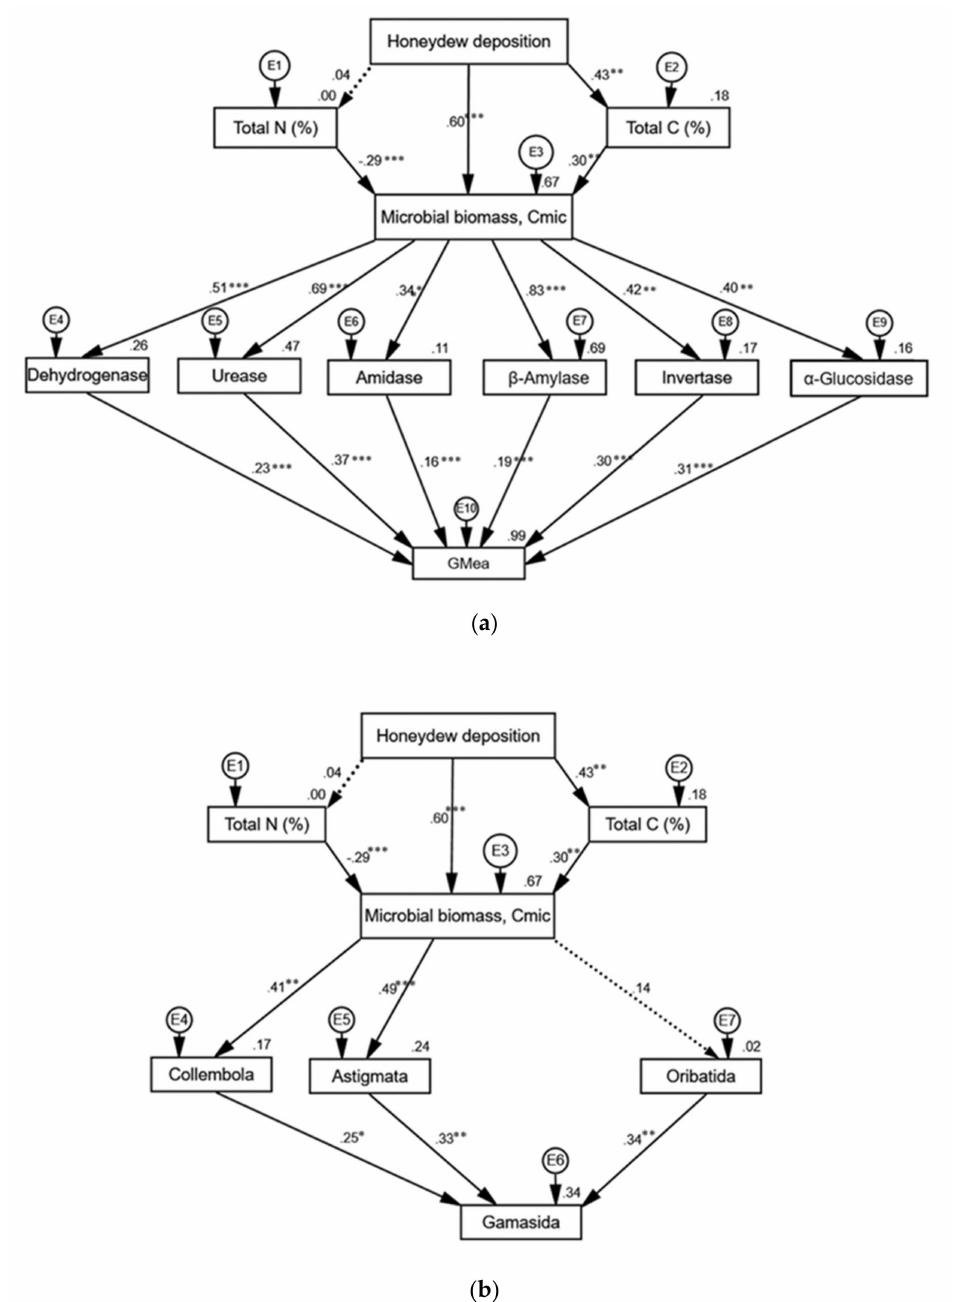
Figure 8. Path diagrams for the e ff ects of T. salignus honeydew deposition on ( a ) soil biochemical properties, and ( b ) meso-fauna communities. The circles above the rectangles indicate the error terms. The solid and dotted arrows represent significant and non-significant associations, respectively. The path coe ffi cients are the standard regression weights, with asterisks showing di ff erent levels of significance (* p < 0.05, ** p < 0.01, *** p < 0.001). The squared multiple correlations (r 2 ) are expressed above the top right corner of each